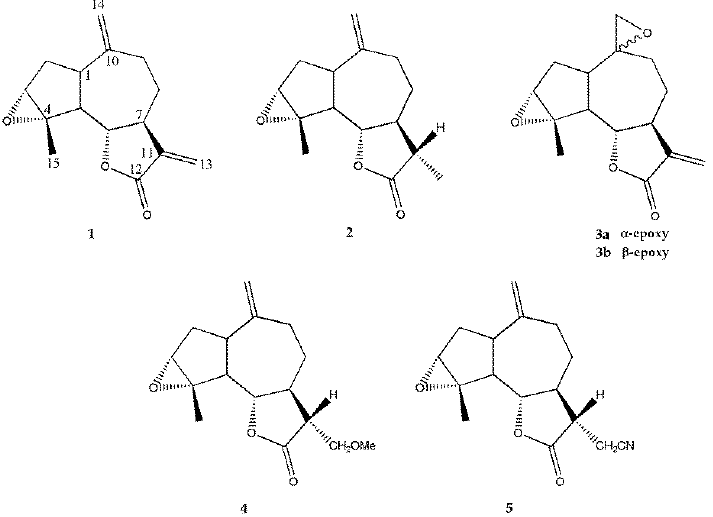
Figure 1. Chemical structures of estafietin ( 1 ) and its derivatives ( 2–5 ).